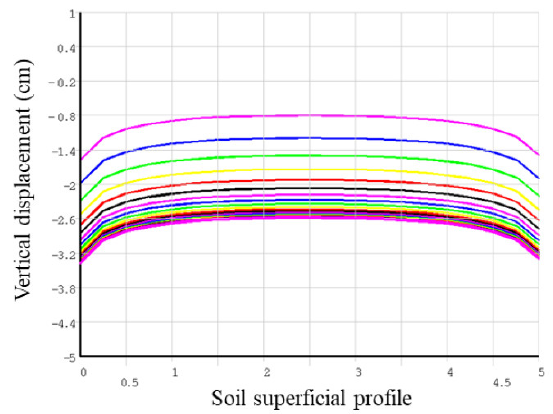
Figure 5. Soil superficial profile of the vertical displacements.